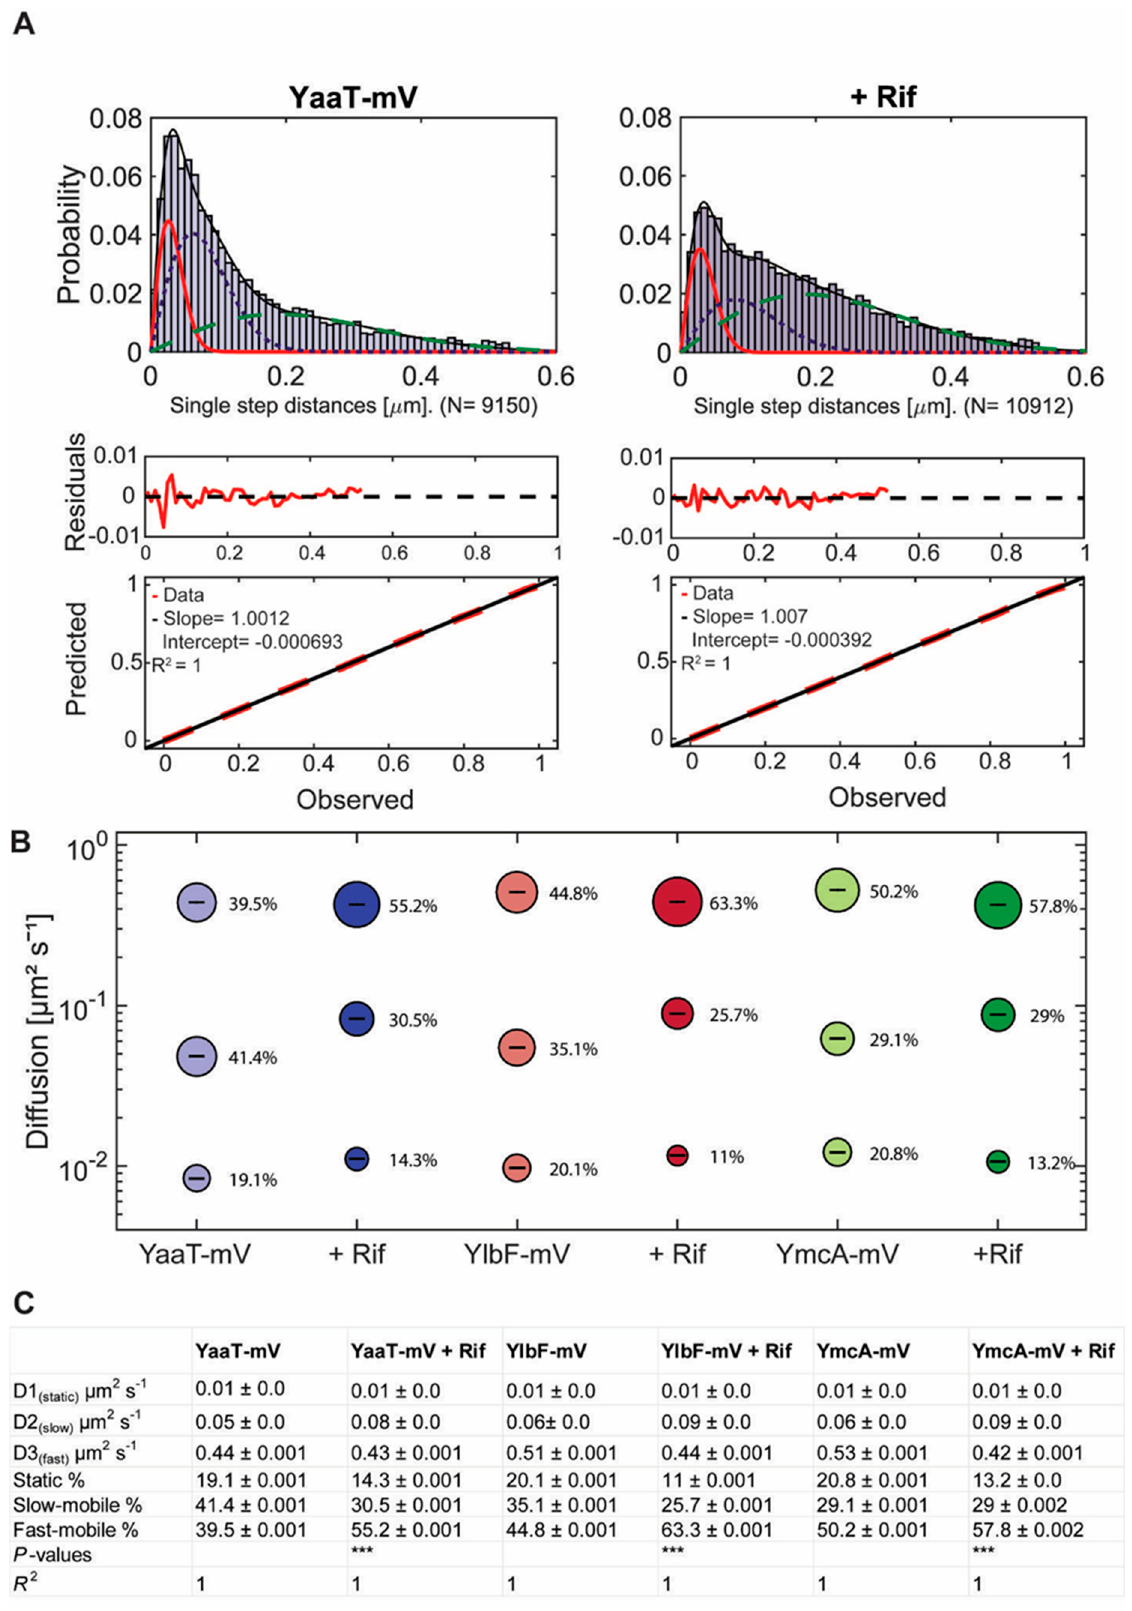
Figure 4. Squared displacement (SQD) analysis of Y-complex-mV fusion proteins under different conditions in cells growing in mid-exponential phase. ( A ) Three Rayleigh distributions were used to fit the observed data and to calculate diffusion coefficients for individual diffusive populations